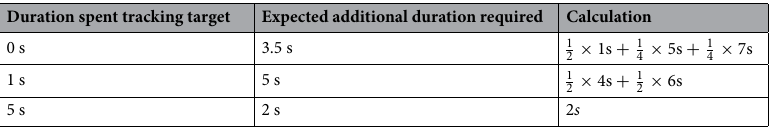
Table 2. Expectations for tracking durations. Expected values for additional tracking required to receive the reward depended on the duration already spent tracking and the likelihood for which trial duration was in